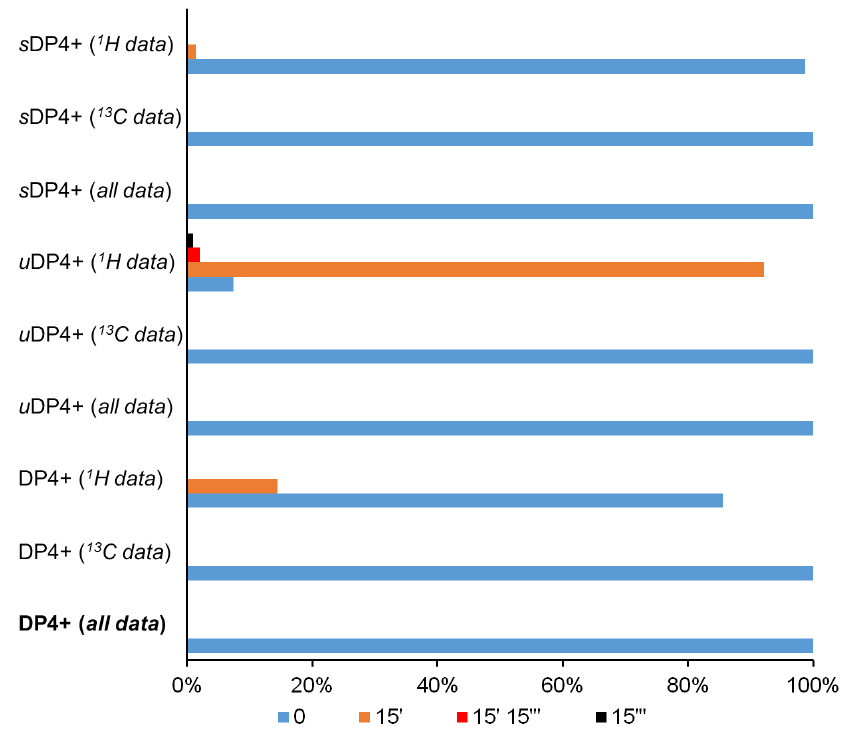
Figure 12. Graphs of the DP4+ probability distribution (%) of the diastereomers of alasmontamine A, obtained by correlating calculated vs. experimental NMR data. Minor isomers with molar fractions of less than 1% are not visible on the diagram.